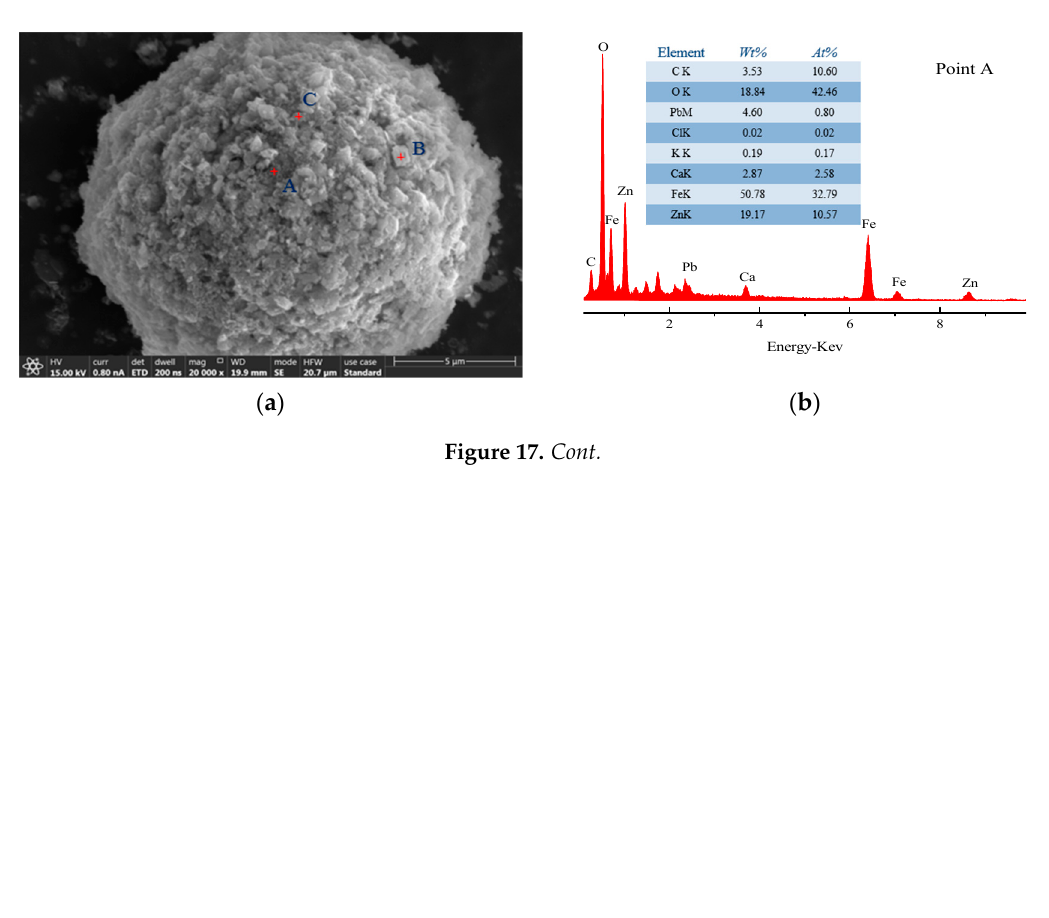
Figure 16. ( a ) SEM pattern of SZO; ( b ) EDS pattern of point A; ( c ) EDS pattern of point B; ( d ) EDS pattern of point C.